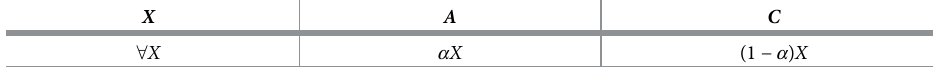
Table 4. Definition of A and C if a deductible with participation α 2 (0, 1) is applied. X A C 8 X